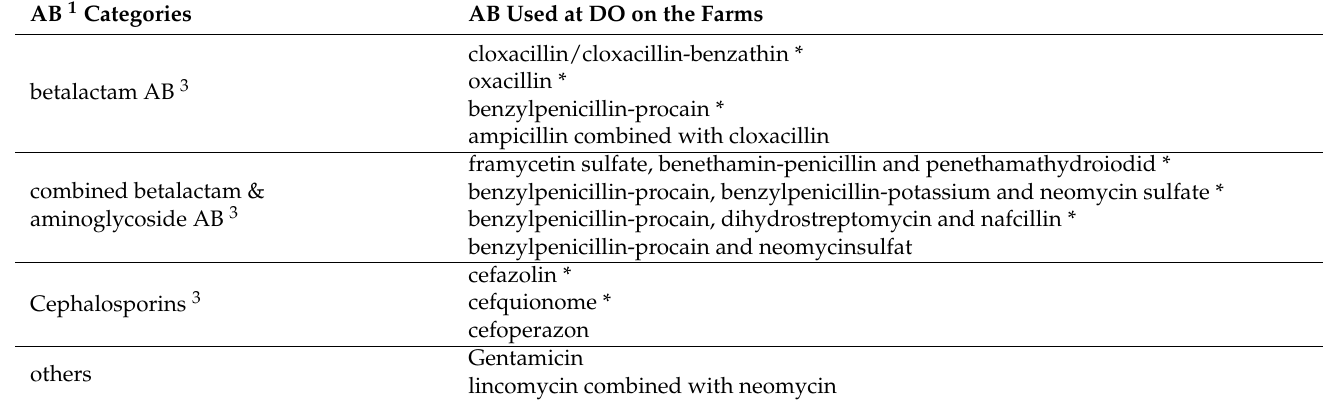
Table 5. All AB 1 mentioned in the primary dataset for use at DO 2 and AB left in the final dataset (*), within